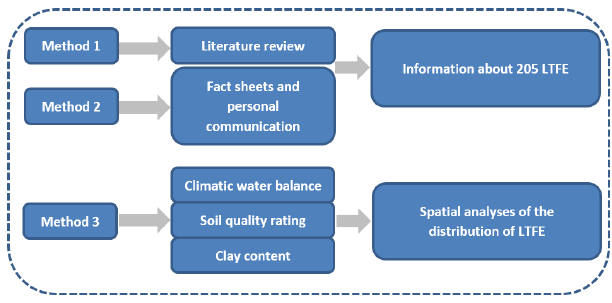
Figure 1. Methods used for assessing the representativeness of the LTFE distribution in